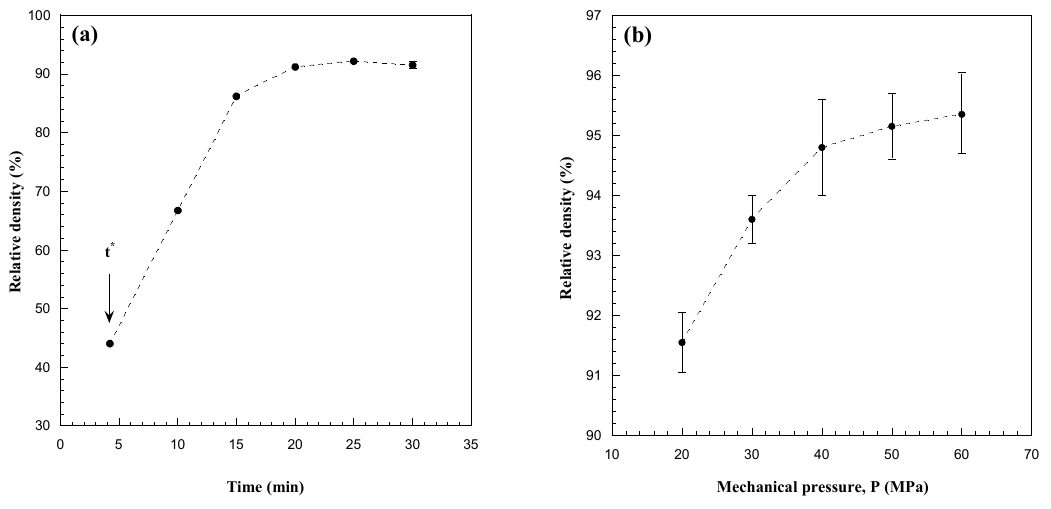
Figure 5. Effect of ( a ) sintering time ( I = 1300 A, P = 20 MPa) and ( b ) mechanical pressure ( I = 1300 A, t = 30 min) on the density of TaB T Adapted from